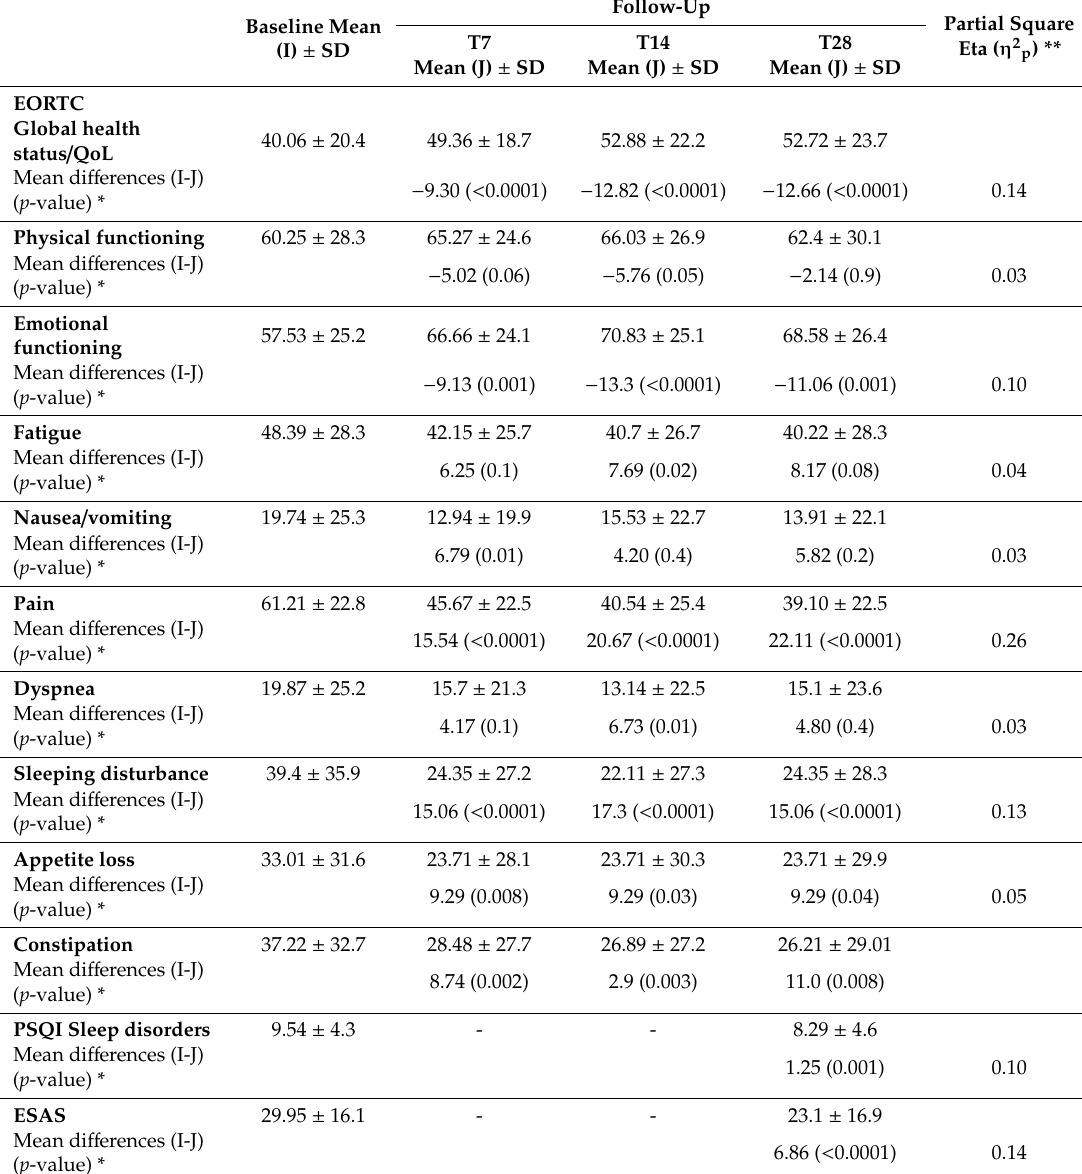
Table 3. General linear model analyses: mean score of quality of life at baseline until last